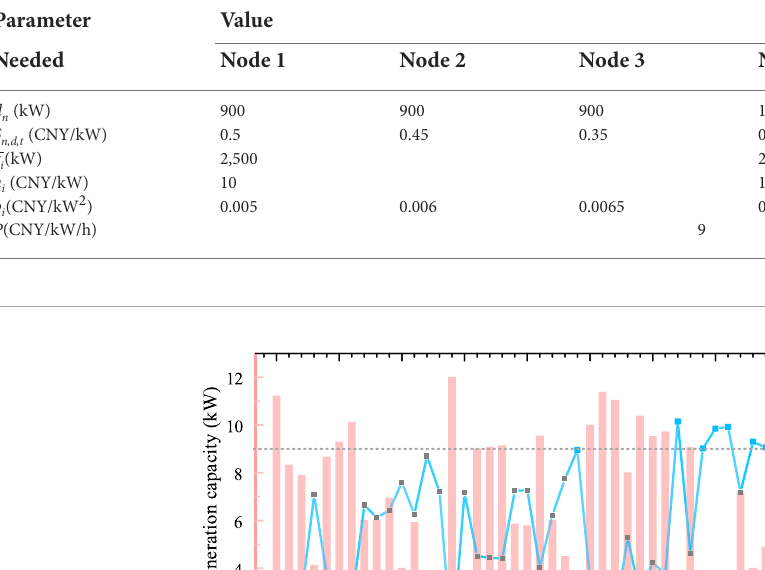
TABLE 1 Parameters of the 6-node